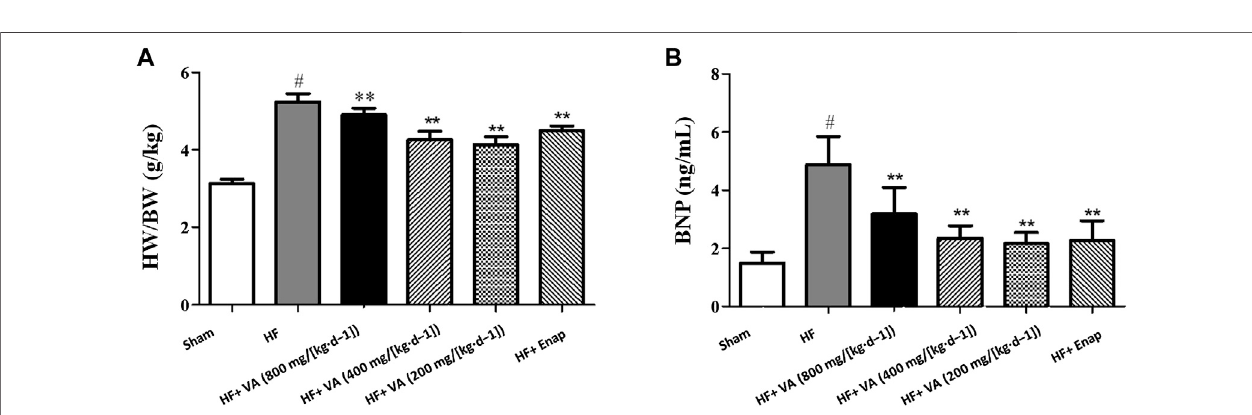
FIGURE 2 | The effect of velvet antlers (VA) on the heart mass index (HMI) (A) and serum BNP levels (B) . The data are expressed as means ± SEM. #: p < 0.05 vs. the sham group; *: p < 0.05 vs. the heart failure (HF) group; **: p < 0.01 vs. the HF group. n (cid:1) 6. HW: heart weight; BW: body weight; Enap: enalapril.